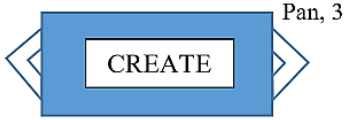
Figure 11. BigchainDB CREATE Transaction.